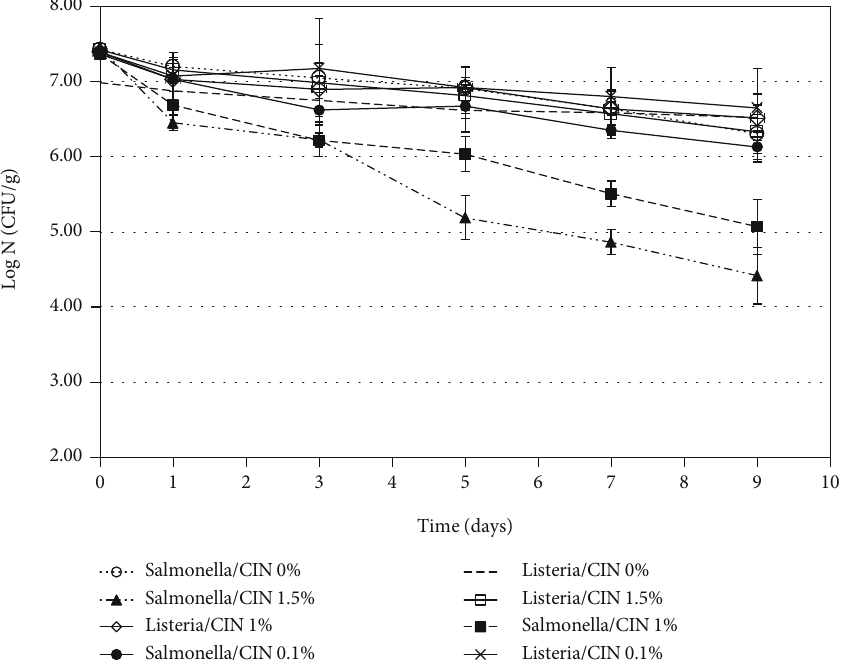
Figure 2: Inhibitory e ff ect of cinnamaldehyde against S. enterica and L. innocua at 25 °